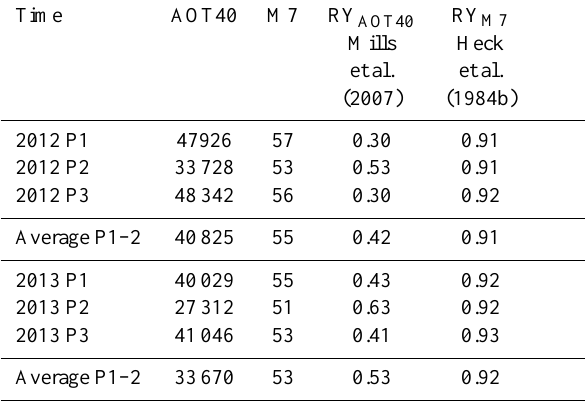
Table 7. Ozone exposure according to different exposure indices and relative yields for cotton. Period 1 (P1) and Period 2 (P2) cor- respond to the periods in which cotton is usually